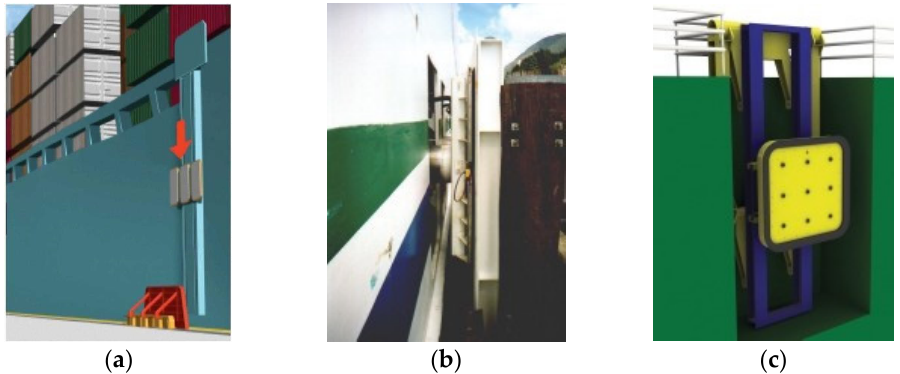
Figure 2. Iron Sailor devices type showing ( a ) Iron Sailor E, ( b ) Iron Sailor I, ( c ) Iron Sailor T (adapted with permission from Ref. [25]. 2022. Cavotec. Ref. [26]. 2013. Cavotec MSL Holdings Limited).